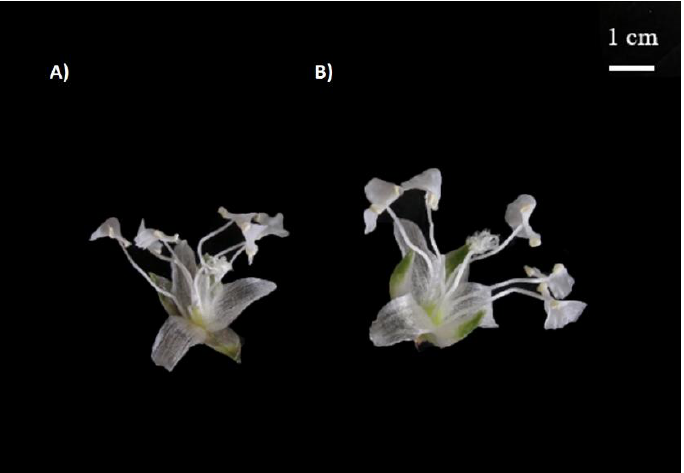
Figure 4. Morphological variation between diploid ( A ) and induced tetraploid ( B ) flowers of C. fragrans cultivated in greenhouse conditions .